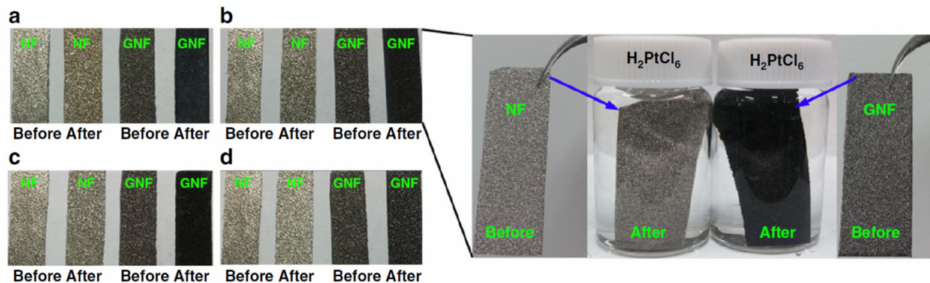
Figure 1. Optical photographs of NF and GNF before and after metal deposition in different elec- trolytes. ( a – d ) Comparison of NF and GNF before and after 1 h deposition in ( a ) 0.09 mM HAuCl 4 (pH = 4.2), ( b ) 0.09 mM H 2 PtCl 6 (pH = 4.5), ( c ) 0.9 mM AgNO 3 (pH = 5.3), and ( d ) 0.9 mM CuSO 4 (pH = 4.6), respectively. Reprint with permission from Ref [38]. Copyright 2018 Nature.